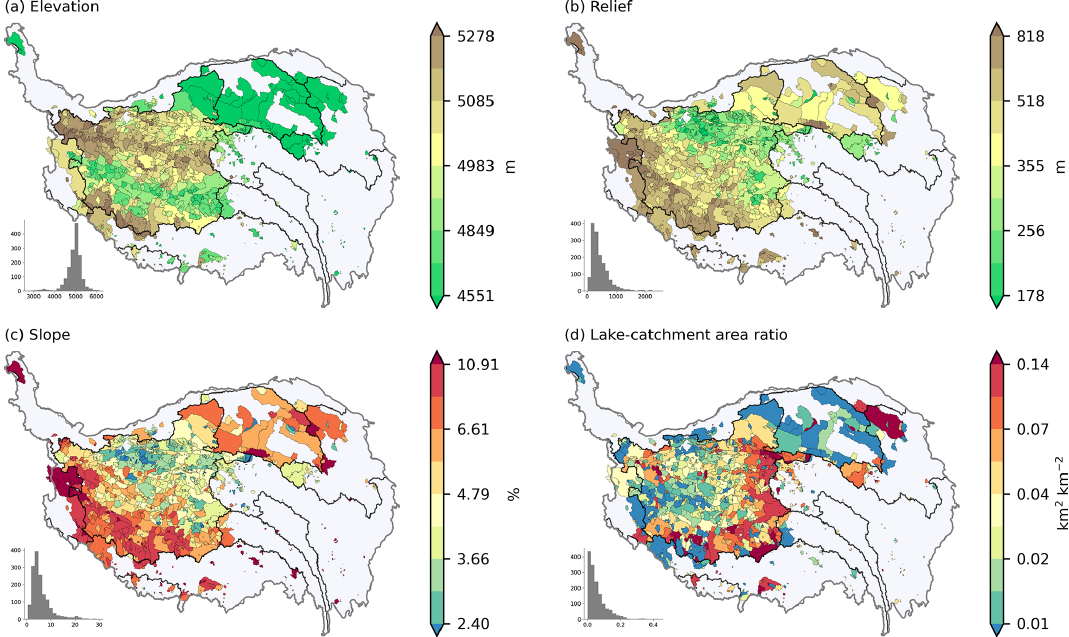
Figure 7. Spatial distribution of mean elevation (a) , relief (b) , slope (%) (c) , and lake-catchment area ratio (d) for inter-lake catchments on the TP. The relief was calculated using a window size of 11 × 11 based on a DEM of 0.00833 ◦ resolution.